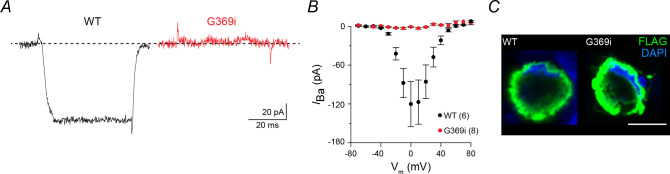
Characterization of G369i mutation in transfected HEK293T cells.(A) Representative Ba2+ currents (IBa) evoked by 50 ms voltage step from −80 to 0 mV in HEK293T cells co-transfected with wild-type (WT) (black) or G369i (red) Cav1.4 channels and auxiliary subunits β2 and α2δ−4. (B) Graph showing I–V relationship for cells co-transfected with WT or G369i mutant channels. IBa was evoked by 50 ms voltage steps from −70 to +70 mV in +10 mV increments. IBa is plotted against each test voltage (Vm). Points represent mean ± SEM. Parentheses indicate number of cells. (C) HEK293T cells co-transfected as in A and immunofluorescently labeled using FLAG-tag antibodies. Scale bar = 10 μm.